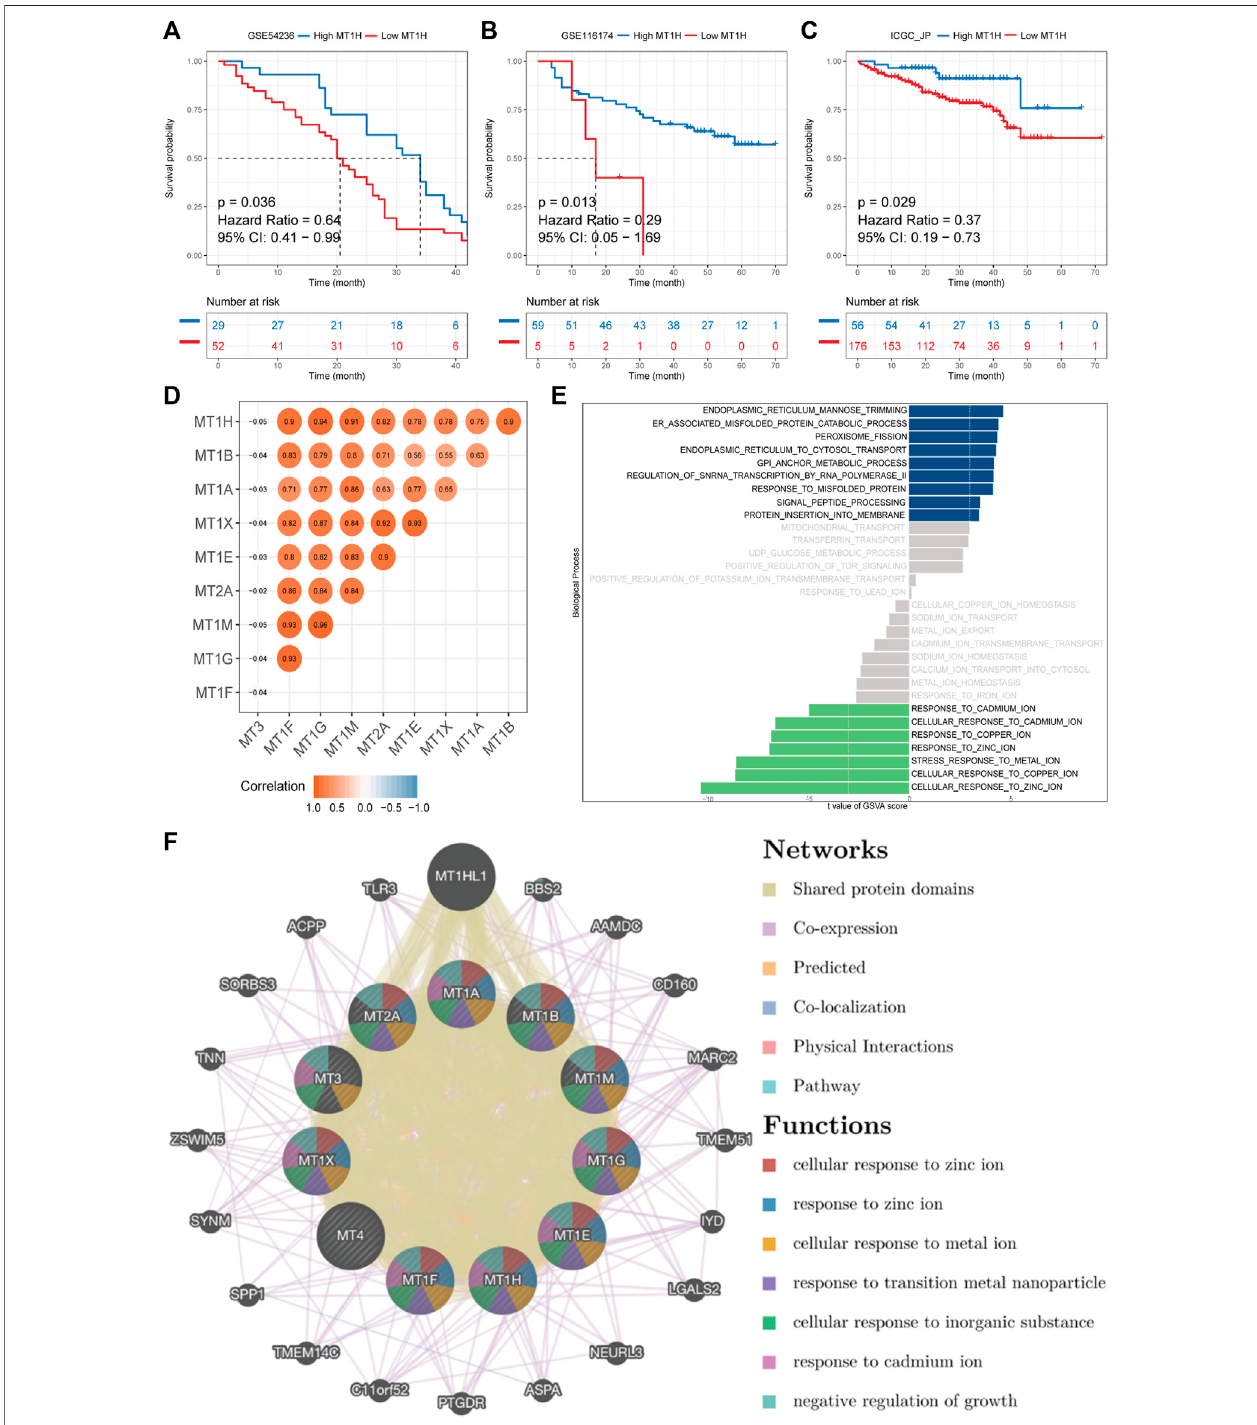
FIGURE6| Externalvalidation,mutualcorrelations,andgene – geneinteractionnetworkofMTsinHCC. (A – C) Kaplan – Meiersurvivalanalysesof MT1H expression in GSE54236, GSE116174, and ICGC-LIRI-JP cohorts externally validate the prognostic value of MT1H . (D) The mutual correlation matrix shows positive Spearman ’ s correlationofMTfamilymembers. (E) ssGSVAonthebiologicalprocessbetweensampleswithhighorlow MT1H expression. (F) Gene – geneinteractionnetworkamong MT isoforms. Each node represents one MT family member. The size and color of nodes represent the strength of interactions and genetic functions, while the line color represents the types of gene – gene